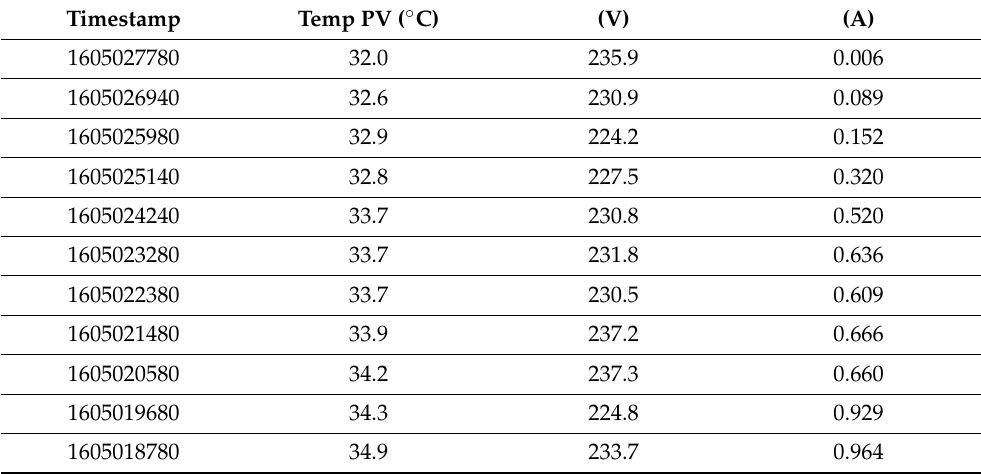
Table 1. Extract with the purchased data, using the Poket portal, in two days of monitoring, of the HyREI product.